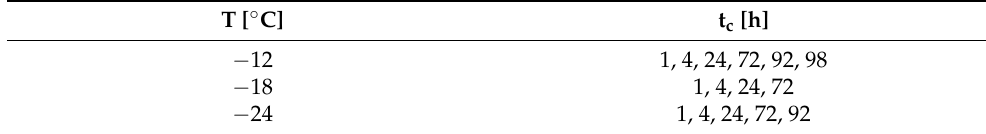
Table 2. Test temperatures and conditioning times adopted in BBR tests.